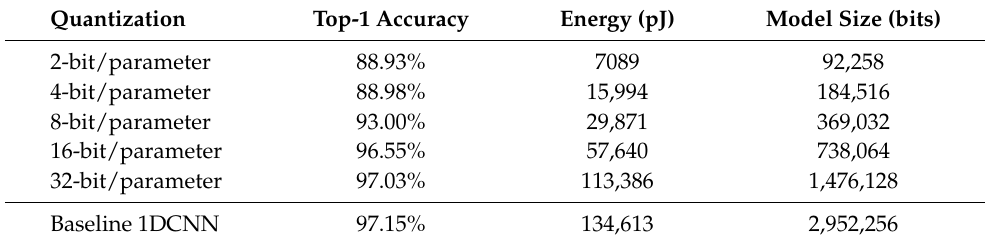
Table 4. Model quantization